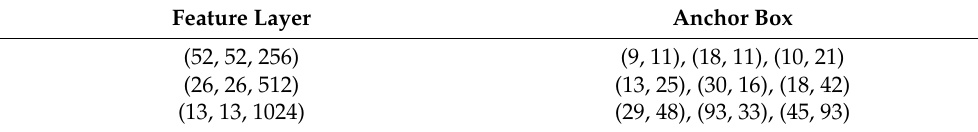
Table 4. Optimized anchor